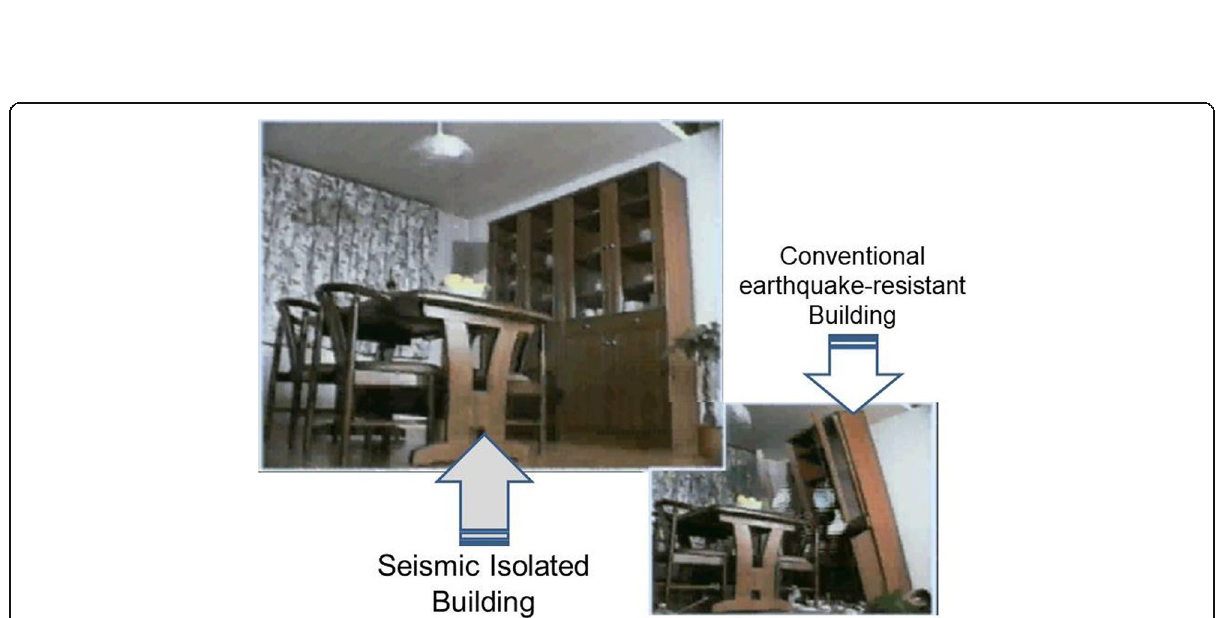
Fig. 9 Mid-story seismic isolated building (Main building of Shimizu Institute of